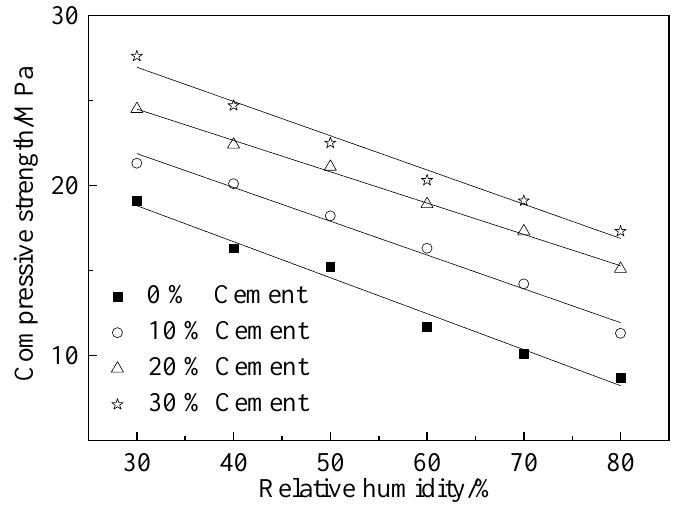
Figure 6. The relationship between compressive strength and relative humidity. Table 7. The fitting results of the flexural strength ( f t ) and relative humidity ( R H ). Equation Cement Content